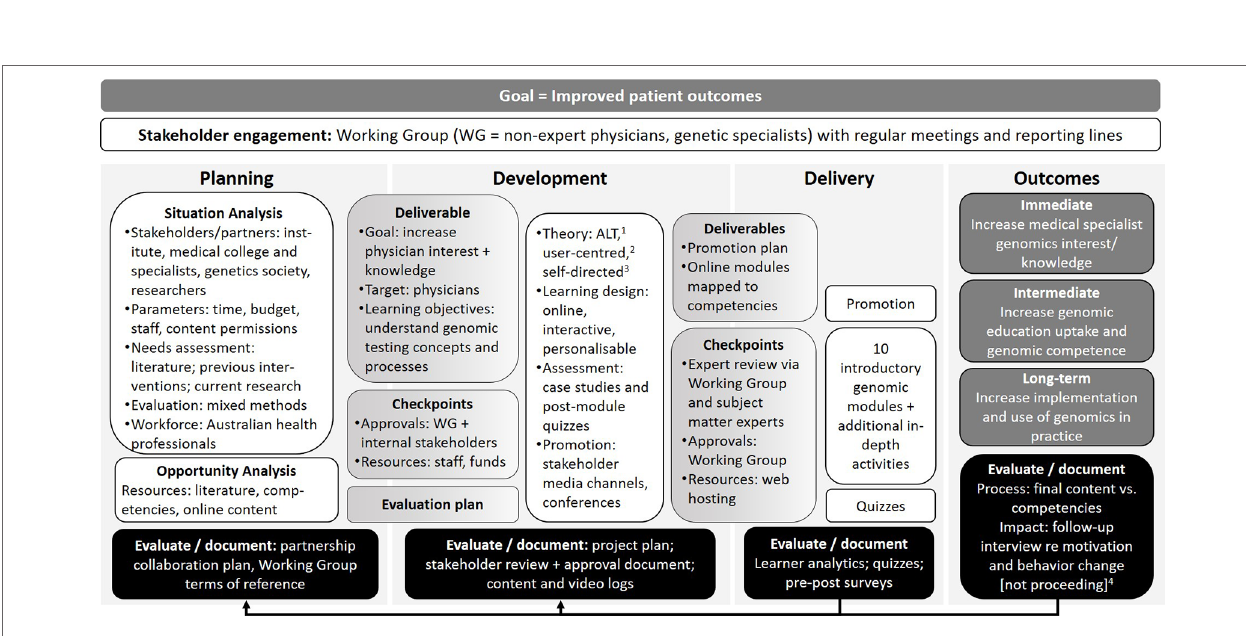
FIGURE 4 | Illustration of how the program logic model can be used as a tool for reflection and targeted evaluation for quality improvement. 1 Adult learning theory (Taylor and Hamdy, 2013); 2 (Beetham and Sharpe, 2013); 3 (Hase, 2009). 4 The impact evaluation is not proceeding due to low